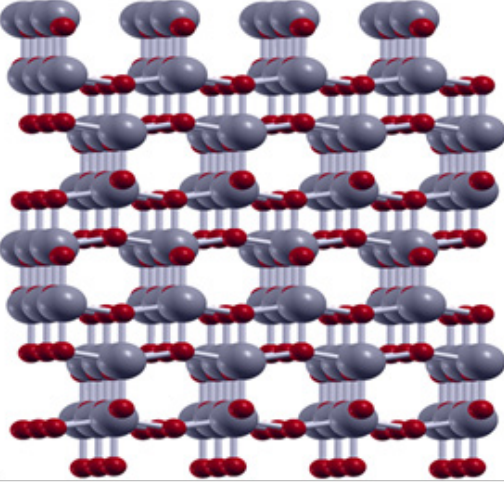
anatase. Colors represent 2